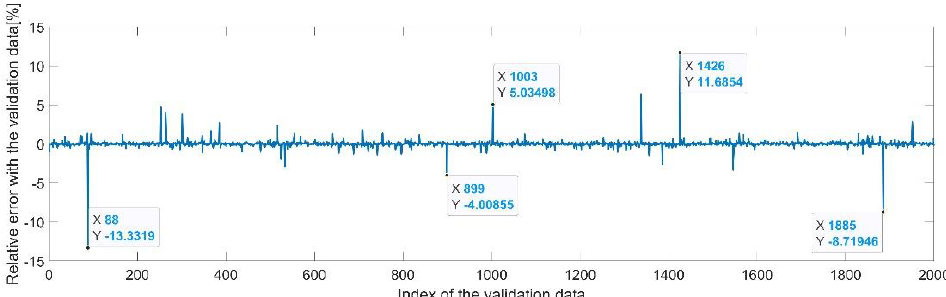
Figure 29. Relative errors between the target values and the predicted values for 𝑞 6 .